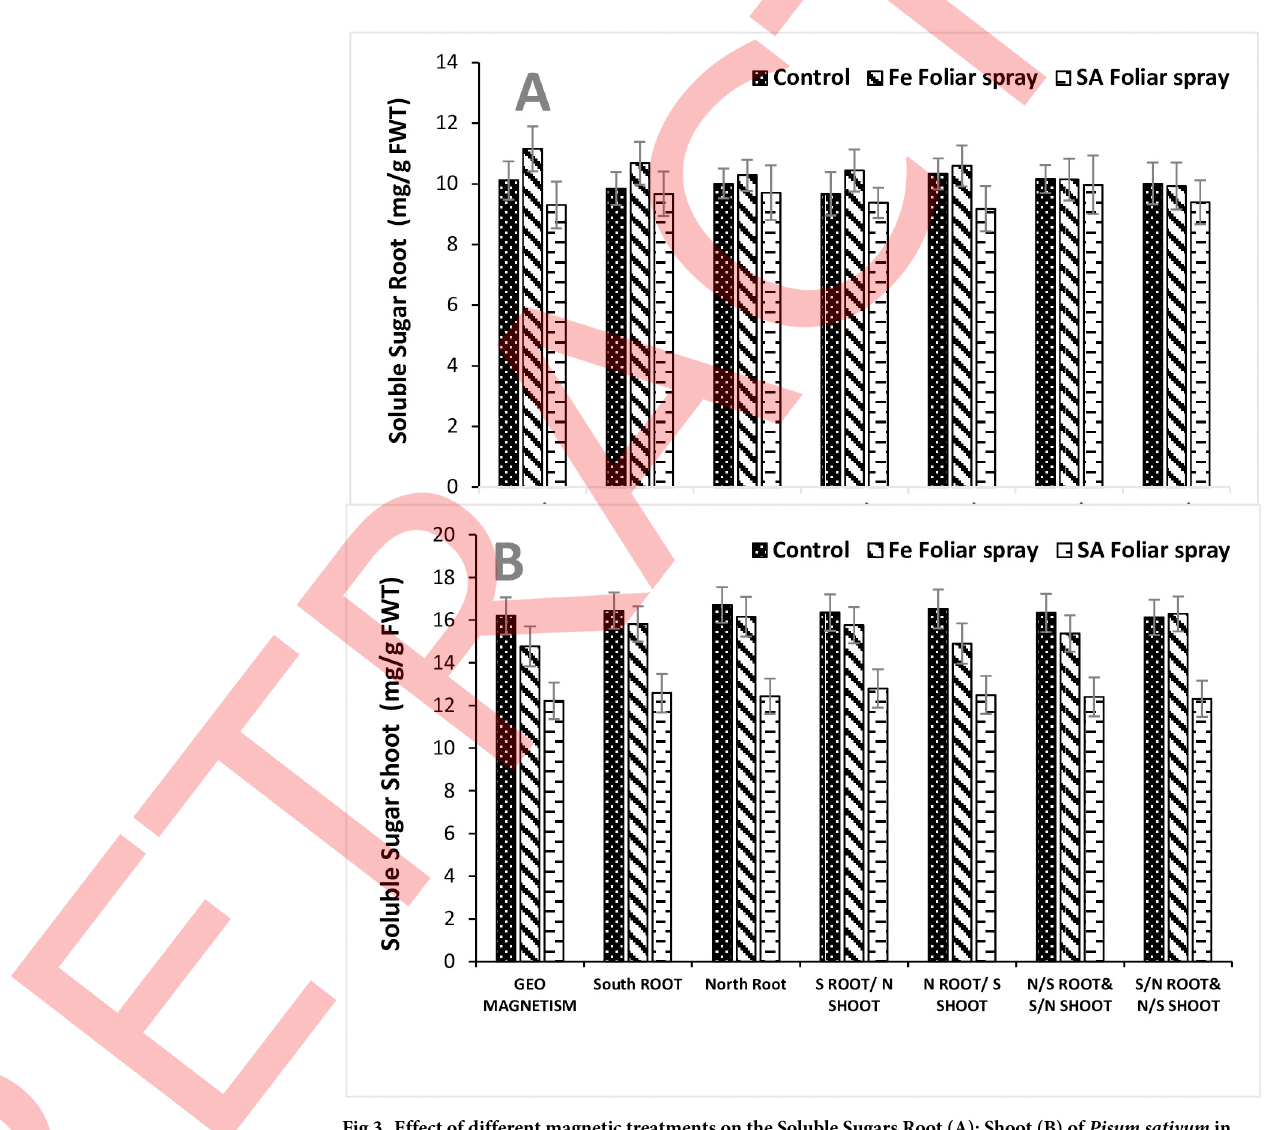
Fig 3. Effect of different magnetic treatments on the Soluble Sugars Root (A); Shoot (B) of Pisum sativum in response to Fe and SA Foliar Spray. The same letters on graphs represent statistically similar effect (P < 0.05).